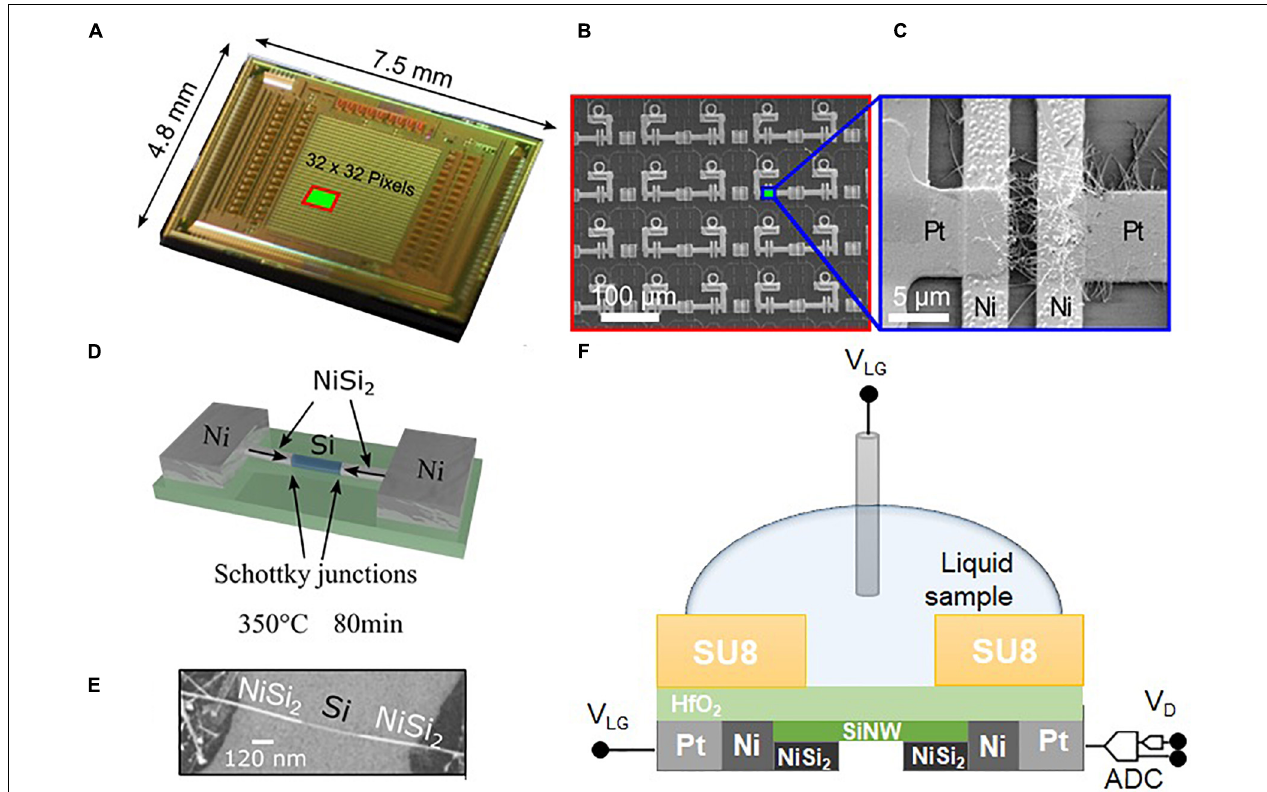
FIGURE 1 | (A) Micrograph of the SiNW-CMOS chip. (B) SEM image of the SiNW SJ-FET array after connecting the floating lid to the CMOS access points, for a chip area as indicated in panel (A) . (C) SEM image of one single device showing a bundle of SiNWs captured between FLO and COM and clamped by Ni contacts. (D) Schematic view of a device during nickel silicide formation by annealing at 350 ◦ C. (E) SEM image of the silicide formation along a single SiNW fabricated on an Si/SiO 2 substrate under the same experimental conditions as the SiNW SJ-FETs integrated in the CMOS chip. The nano-Schottky junctions within the nanowires are formed by the metallic NiSi 2 segments with atomically abrupt and flat junctions towards the pristine SiNW. (F) Cross section of an individual SiNW SJ-FET sensing device with liquid